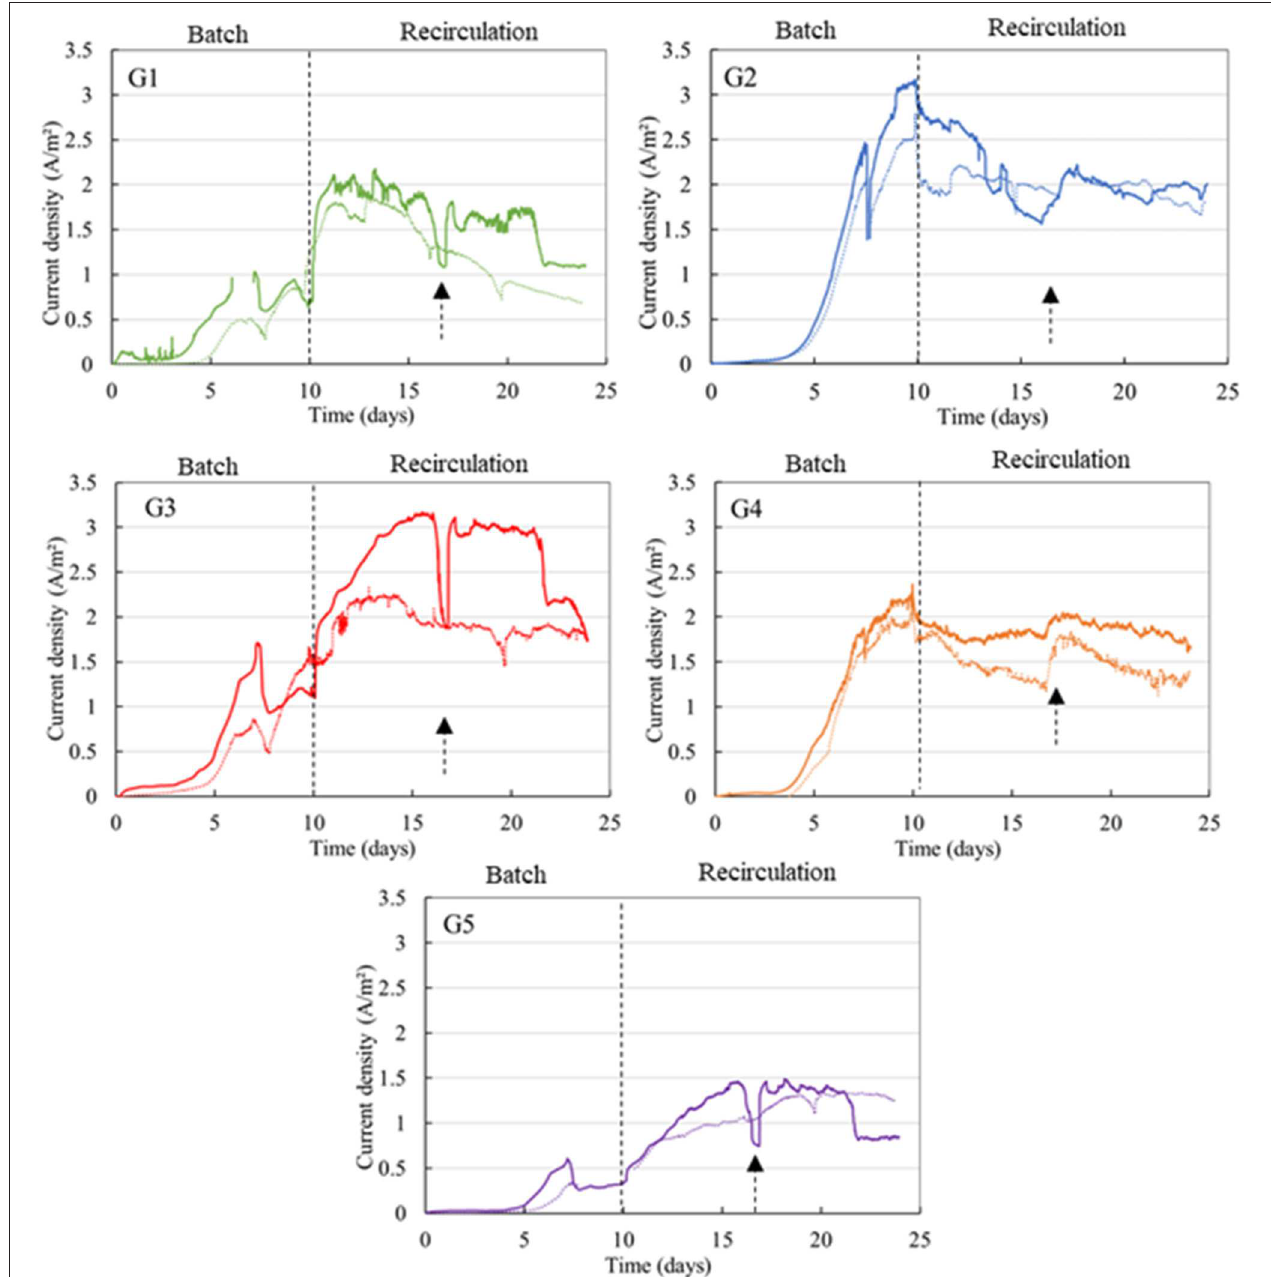
FIGURE 1 | Chronoamperometries (CA) for dWW-fed graphite bioanodes. The reactors were initially conducted in batch mode for 10 days and were then switched to recirculating mode (dashed line) in closed loop with a 2L tank of hydrolyzed dWW that is renewed at day 17 (dashed arrow). Duplicates were conducted for each electrode graphite grade.